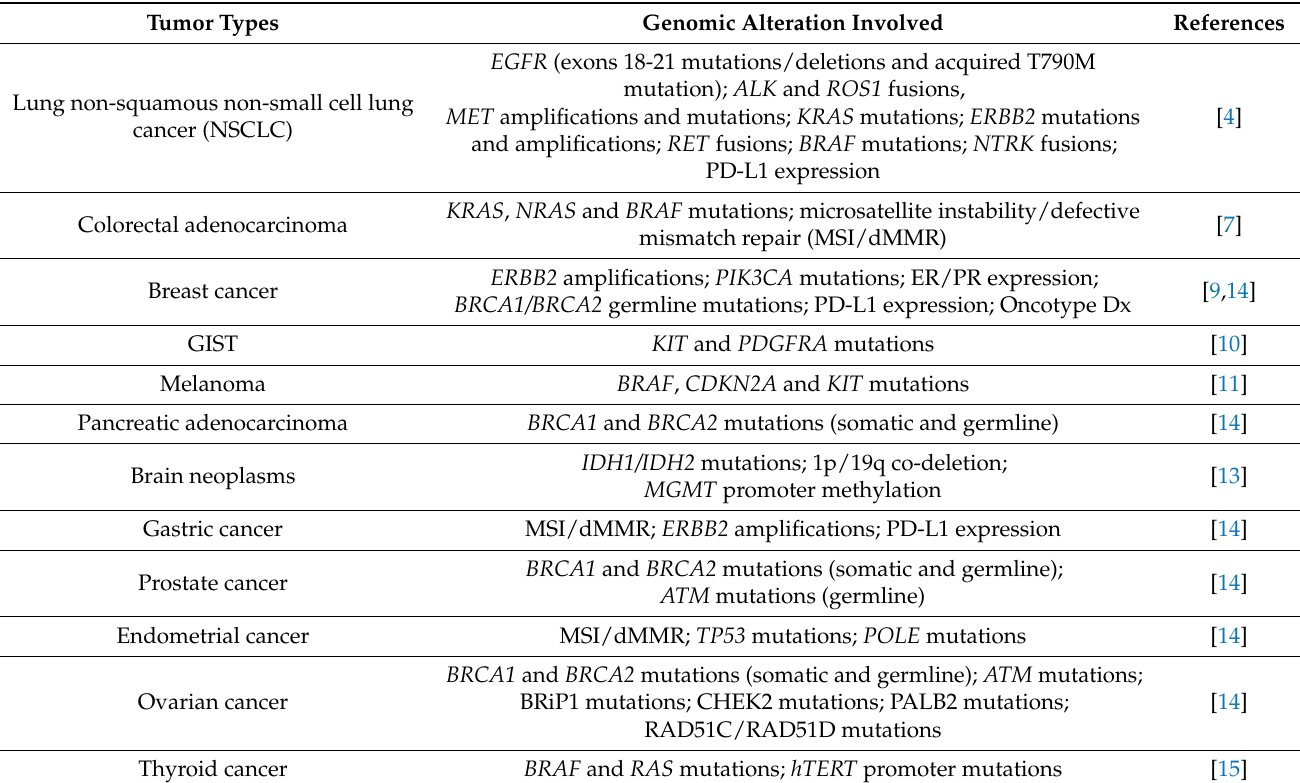
Table 1. Main genomic alterations in different tumor types, as assessed within the clinic. Tumor